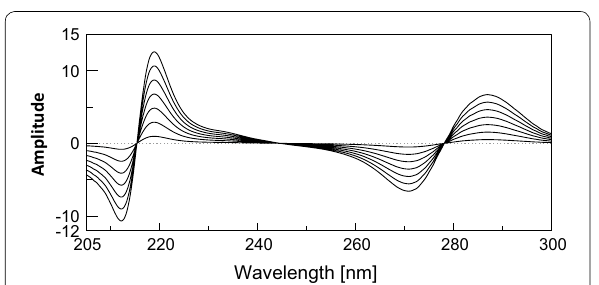
Fig. 7 First derivative of ratio spectra of CAF (2–26 μg/mL) using normalized PCT spectrum as a divisor